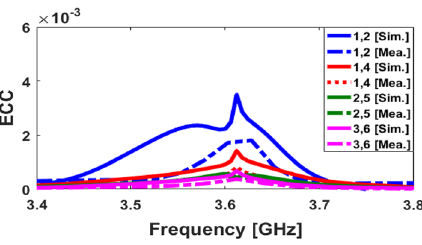
Figure 14. Calculated simulated/measured ECC